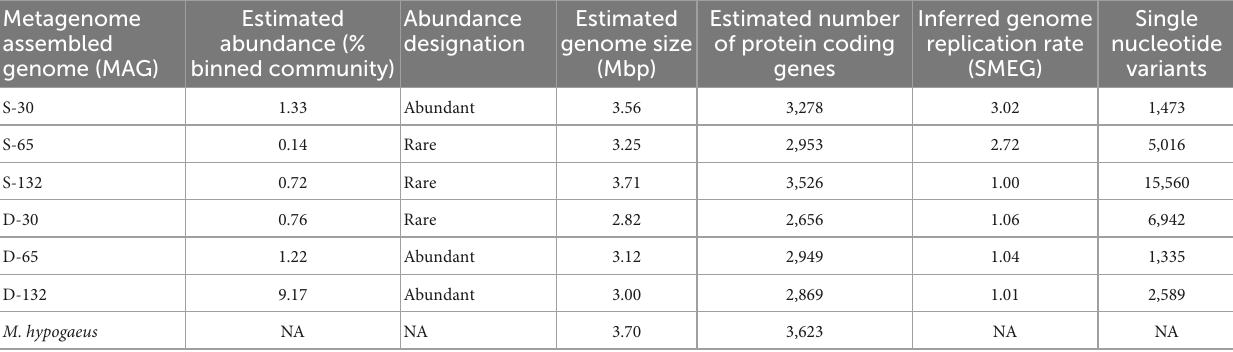
TABLE 2 Name, estimated abundance, estimated genome size (mega basepairs, Mbp), estimated number of protein coding genes, strain level metagenomic estimation of growth rate (SMEG), and number of single nucleotide variants detected for metagenome assembled genomes (MAGs) recovered from discrete intervals in well